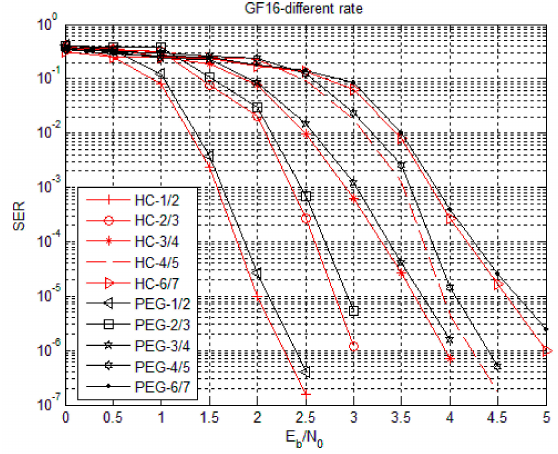
Figure 8. Symbol Error Rate (SER) performance of HC algorithm with Code3.